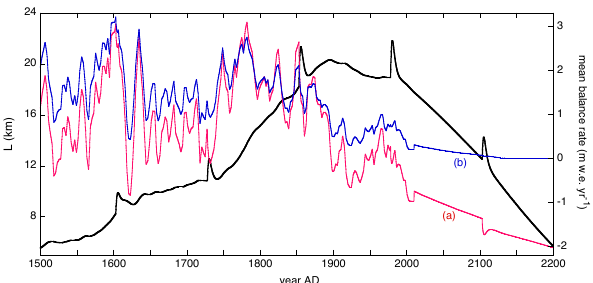
Figure 13. Simulated evolution of Abrahamsenbreen in the case of Fig. 13. Simulated evolution of Abrahamsenbreen in the case of a rise of the equilibrium line 2 a rise of the equilibrium line of 1myear − 1 . Glacier length in black of 1 m yr -1 . Glacier length in black (scale at left). The curve labeled (a) shows the net balance 3 (scale at left). The curve labelled (a) shows the net balance over the over the entire glacier system; the curve labelled (b) given the mass input from the tributary 4 entire glacier system; the curve labelled (b) given the mass input glaciers, expressed as a mean balance rate. 5 from the tributary glaciers, expressed as a mean balance